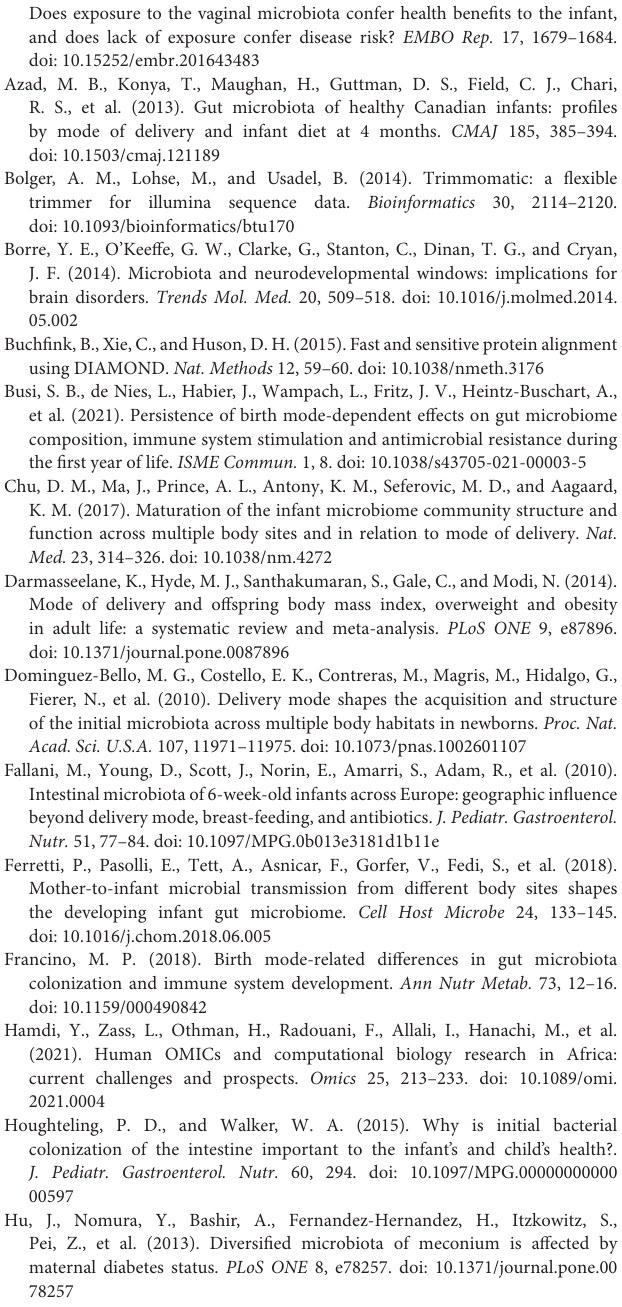
Supplementary Figure 2 | Differentially abundant taxa between elective cesarean section (ECS) and vaginally delivered (VD) newborns detected by linear discriminant analysis effect size (LEfSe) analysis. The blue shaded bars indicate the taxa enriched in the microbiome of VD newborns. The purple shaded bars indicate the taxa enriched in the microbiome of ECS newborns. The prefixes “p,” “c,” “o,” “f,” “g,” “s,” and “s” indicate the annotation levels of phylum, class, order, family, genus, species, and strain, respectively.